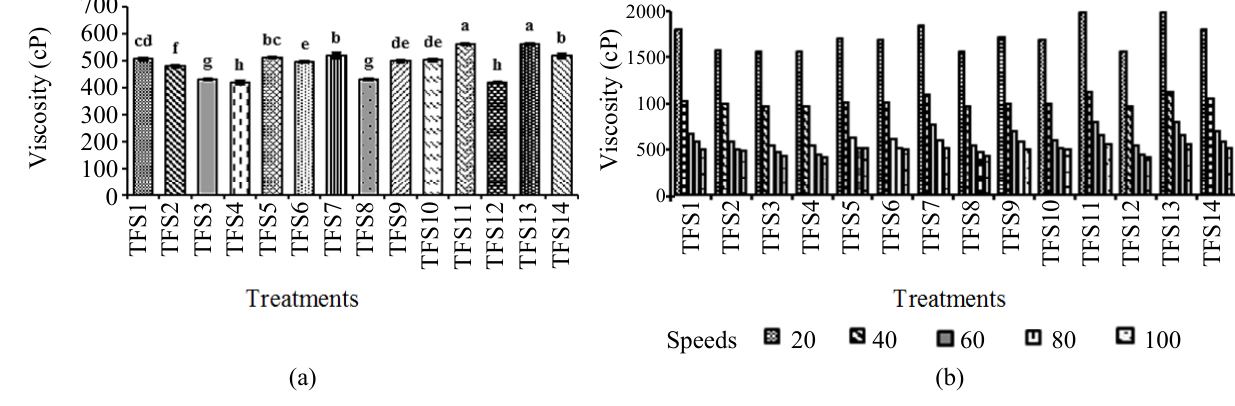
Fig. 3. Viscosity of Vietnamese tamarind fish sauces. Table 2. Sensory acceptability scores of Vietnamese tamarind fish sauce Treatments Appearance Color Odor Texture